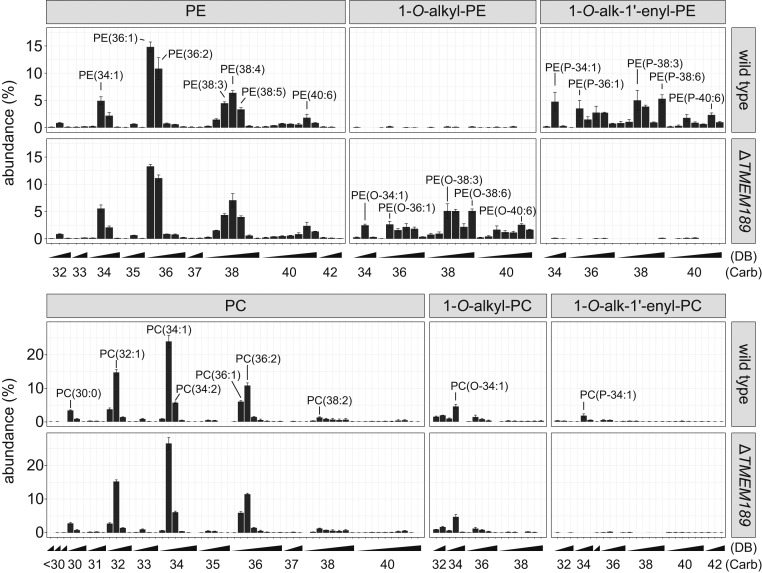
Glycerophosphoethanolamines and glycerophosphocholines in WT and TMEM189-deficient human HAP1 cells. TMEM189-deficient HAP1 cells (∆TMEM189) contain a frame-shift mutation introduced by a CRISPR-Cas9 protocol, leading to a truncated, inactive protein (SI Appendix). Cells were cultured under standard conditions, and lipids were extracted and analyzed by LC-MS/MS as described in Materials and Methods. Mean ± SD of three independent experiments is shown. PC, phosphatidylcholines (ester bond at sn1); PE, phosphatidylethanolamines (ester bond at sn1); 1-O-alkyl PC, plasmanylcholines [ether bond at sn1, PC(O−)]; 1-O-alk-1′-enyl PC, plasmenylcholines [vinyl ether bond at sn1, i.e., plasmalogens, choline type, PC(P-)] 1-O-alkyl PE, plasmanylethanolamines [ether bond at sn1, PE(O-)]; 1-O-alk-1′-enyl PE, plasmenylethanolamines [vinyl ether bond at sn1, i.e., plasmalogens, ethanolamine type, PE(P-)]. Numbers in parentheses give the total number of side chain carbon atoms (Carb), followed by the number of double bonds (DB). To facilitate location of species, selected bars are labeled.